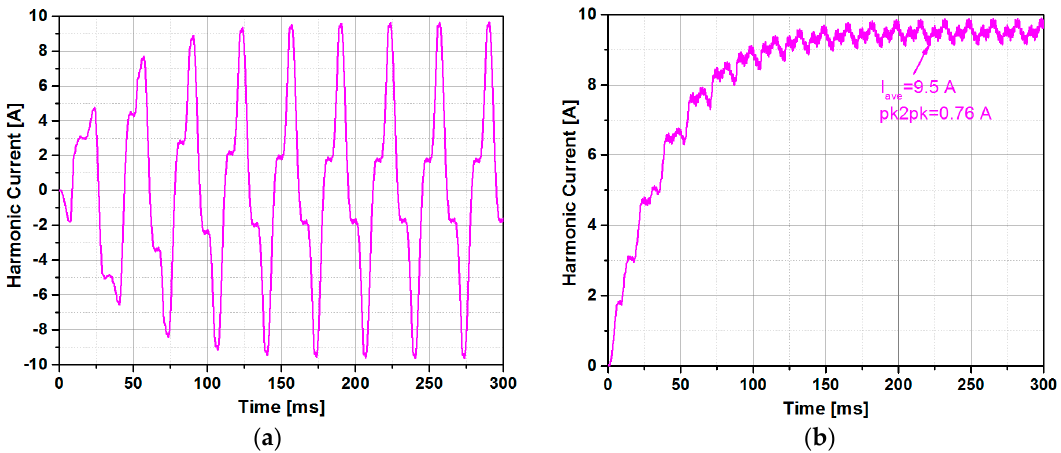
Figure 6. Currents in the rotor windings (basic model): ( a ) harmonic current; and ( b ) field current.